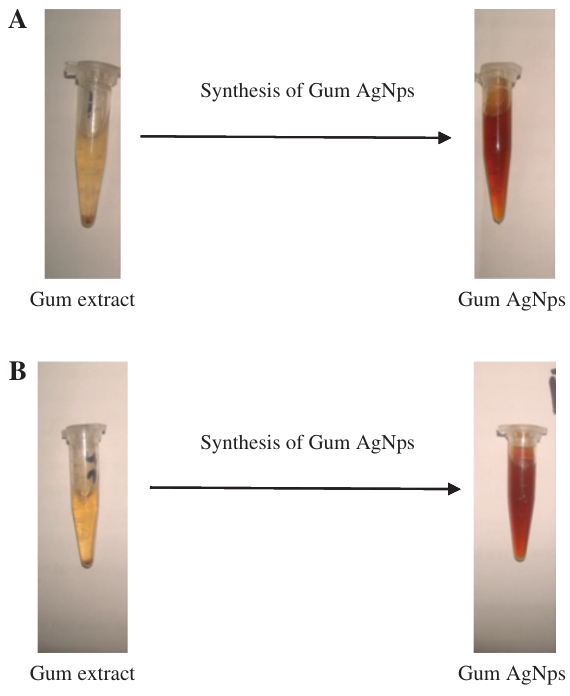
Figure 1: Gum-based AgNPs using A. modesta and D. sissoo gums as binding matrix: (A) A. modesta and (B) D. sissoo